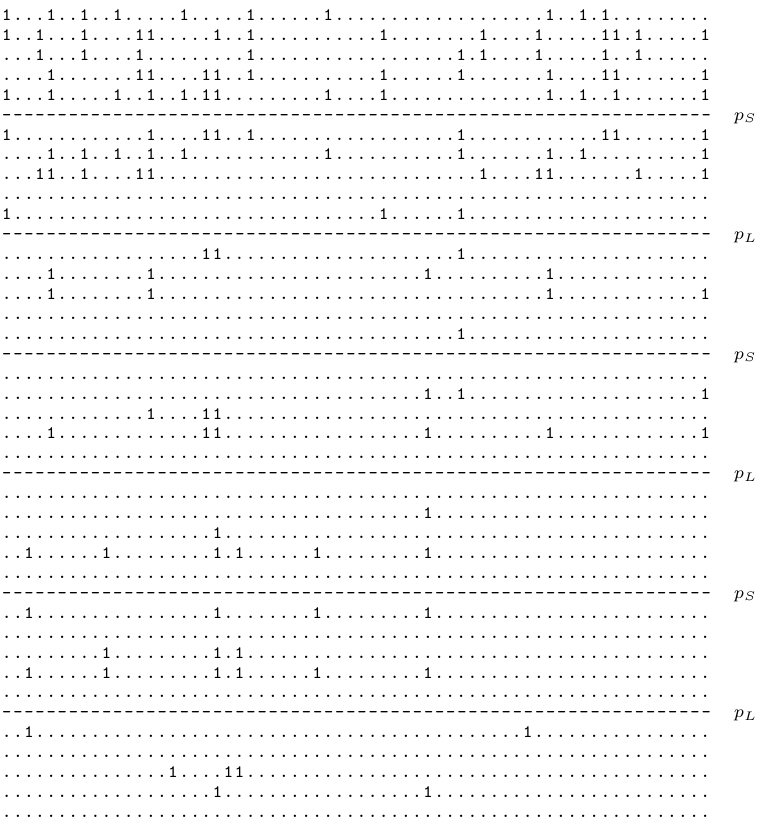
Figure 14: 4-round linear trail with 43 [22, 8, 6, 7] active Sboxes and correlation 54 [27 10 10